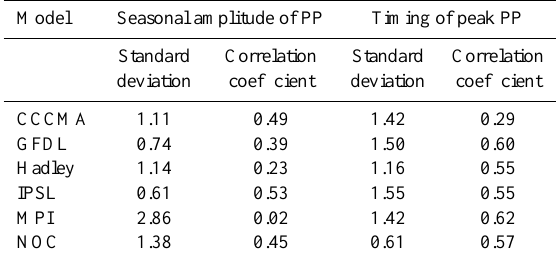
Table 2. Comparison of model-derived seasonality metrics (hind- cast runs, mean of 1985–2005) with those observed in satellite- derived primary production (mean 1998–2007). All correlations (Pearson correlation coefficient) are significant at the 99%